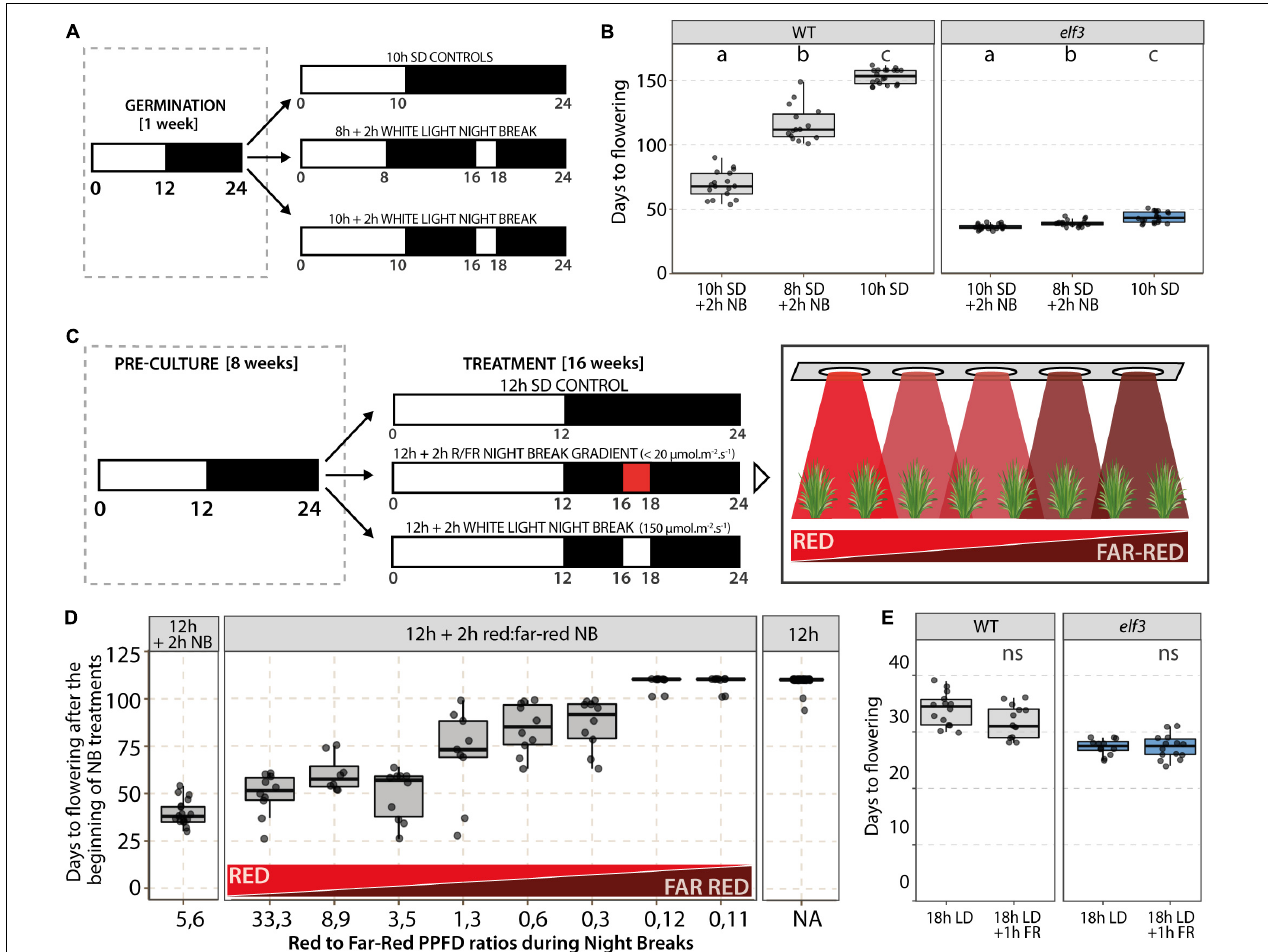
FIGURE 4 | Effect of night breaks and light quality on flowering time. (A) Experimental design and (B) results of night break (NB) experiments performed by exposing wild-type (WT) and elf3 plants growing in either 8 or 10 h photoperiods to a 2 h NB (NB; 150 µ mol.m − 2 .s − 1 ) from Zeitgeber time (ZT) 16 h to ZT18h. Controls were maintained in 10 h SD ( n = 15–20). Note that most of the control plants had not flowered after 150 days in 10 h SD. Letters indicate statistical difference ( p < 0.05) using Tukey’s HSD tests. (C) Experimental design used to test the effect of the red (R) to far-red (FR) ratio during NBs on flowering. (D) Flowering time of plants exposed to a NB under a red to far-red gradient. WT plants were grown in a 12 h photoperiod for 8 weeks before being transferred to a 12 h photoperiod supplemented with a 2 h NB (from ZT16h to ZT18h) under a red to far-red gradient ( n = 8–15 per condition). Control plants were either maintained under a 12 h photoperiod (Right panel) or exposed to a 2 h white light NB (Left panel). (E) Effect of far-red (FR) light on flowering time. At the beginning of the night, WT and elf3 plants grown under an 18 h photoperiod were exposed to 1 h of FR light (25 µ mol.m − 2 .s − 1 ). Control plants were exposed to an uninterrupted night ( n = 15–20); t -test revealed no statistically significant differences